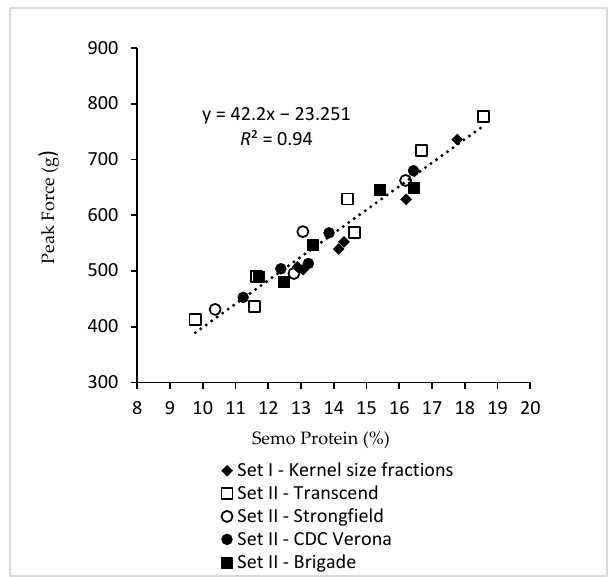
Figure 5. Relationships between semolina protein and spaghetti firmness as measured by peak force for samples in set I and set II.